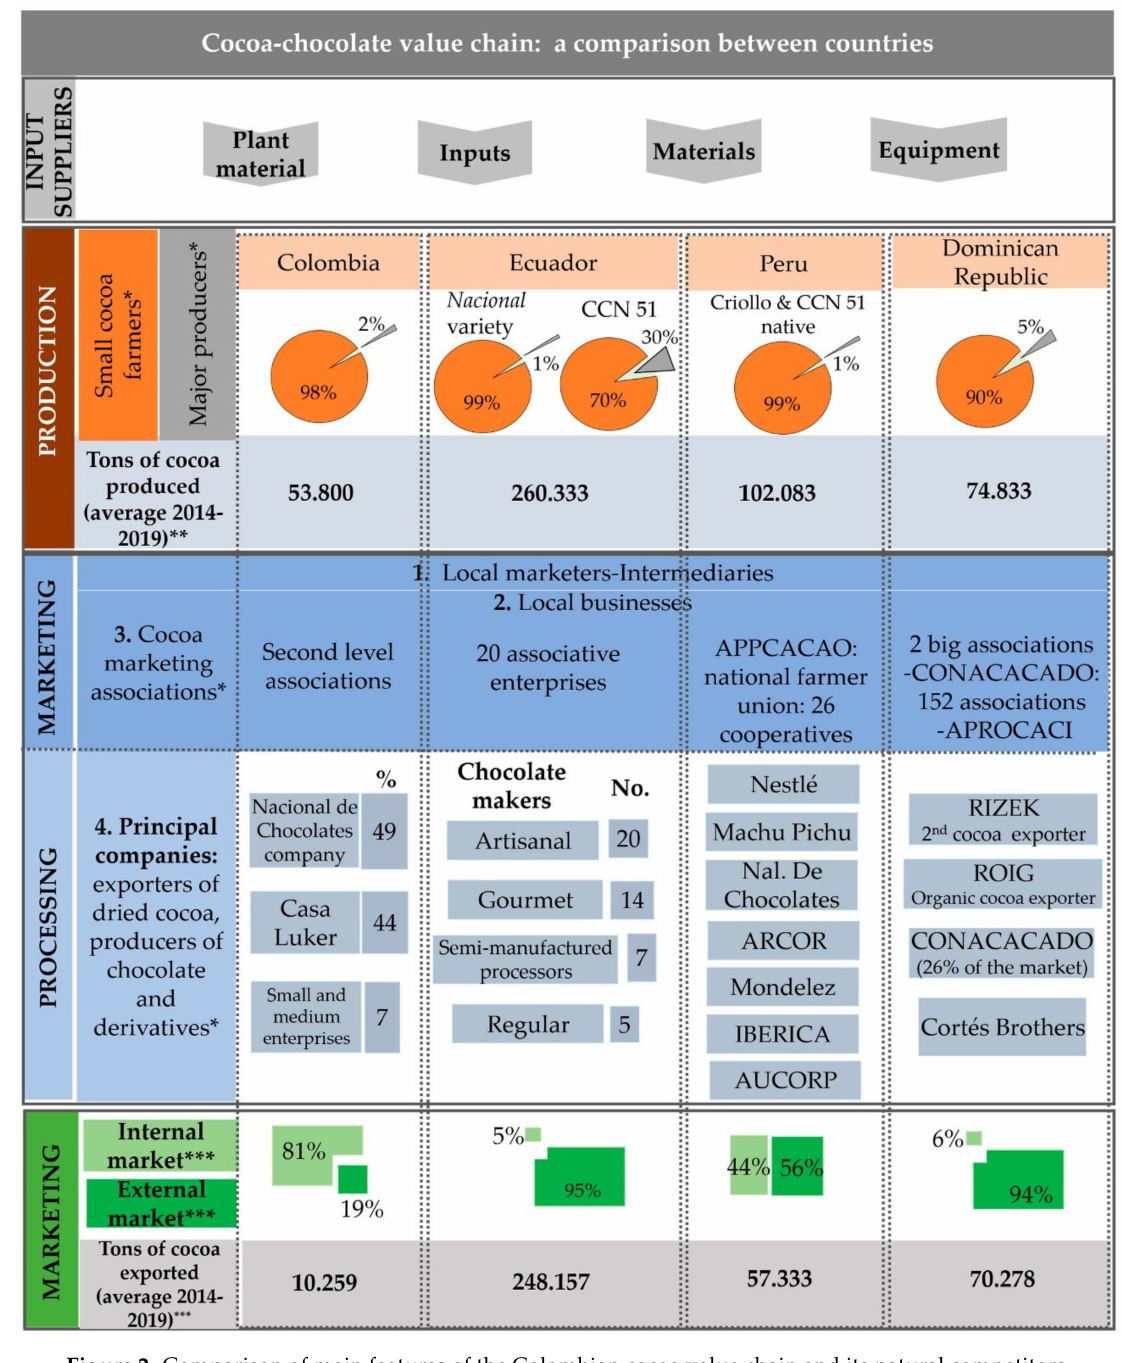
Figure 2. Comparison of main features of the Colombian cocoa value chain and its natural competitors in premium cocoa markets. Sources: * [2], ** [33–36], and ***